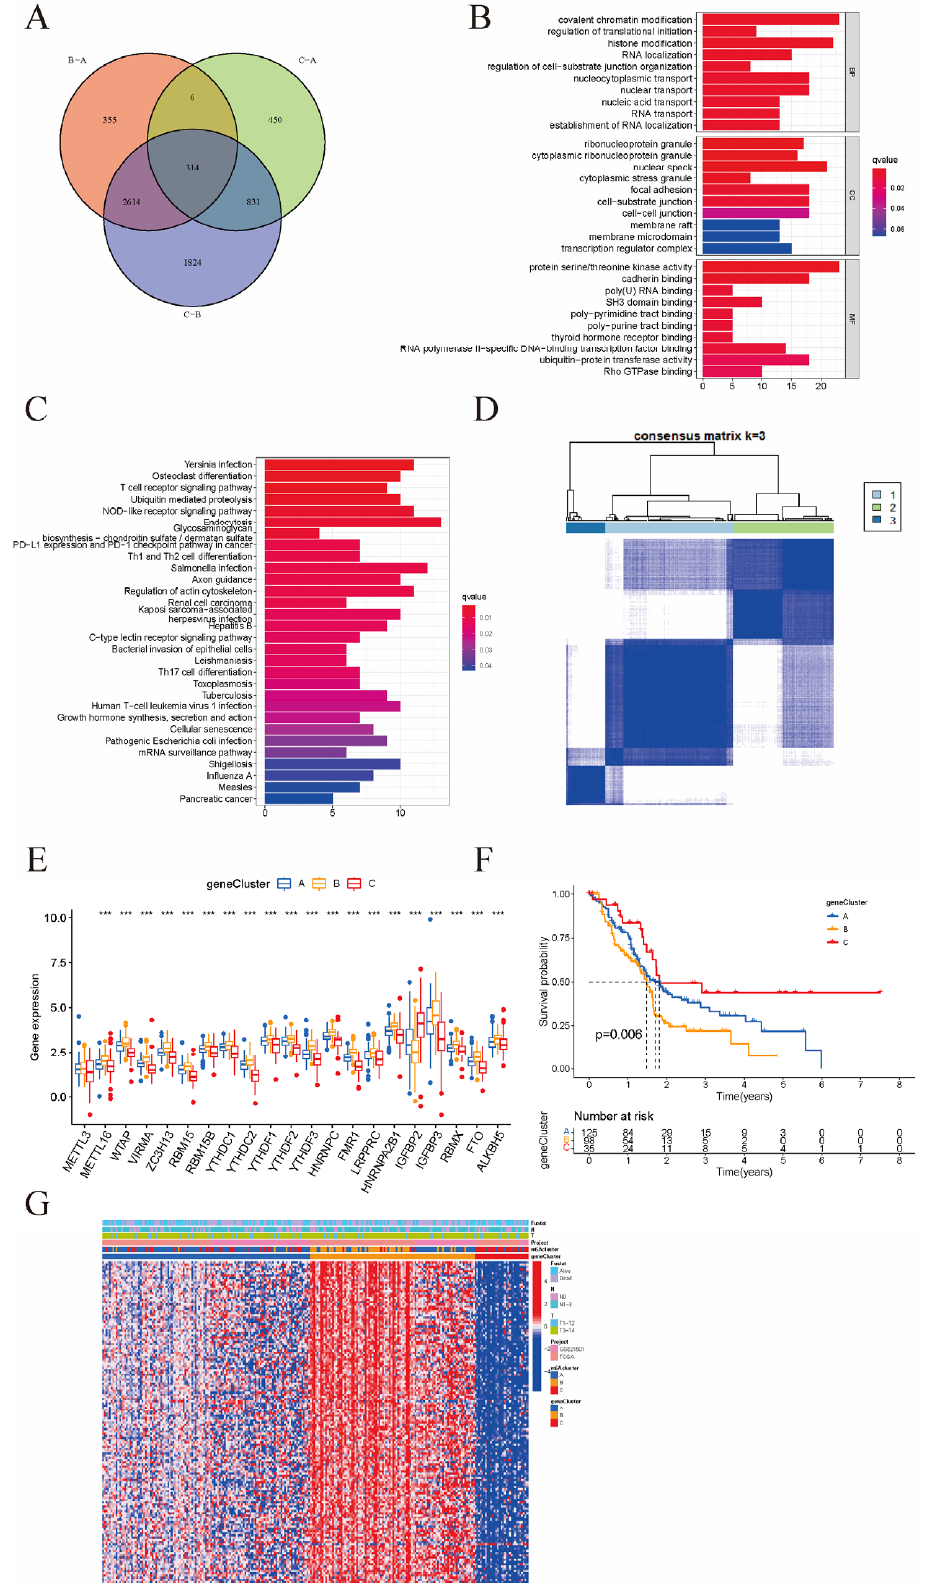
Figure 4. ( A ) Wayne diagram; ( B ) GO enrichment analysis; ( C ) KEGG pathway analysis; ( D ) Prognosis- related gene clusters; ( E ) Expression of m6A-related genes in different gene clusters; ( F ) Survival analysis with different geneCluster; ( G ) Distribution of survival status and disease stage of patients under each type (*** p <